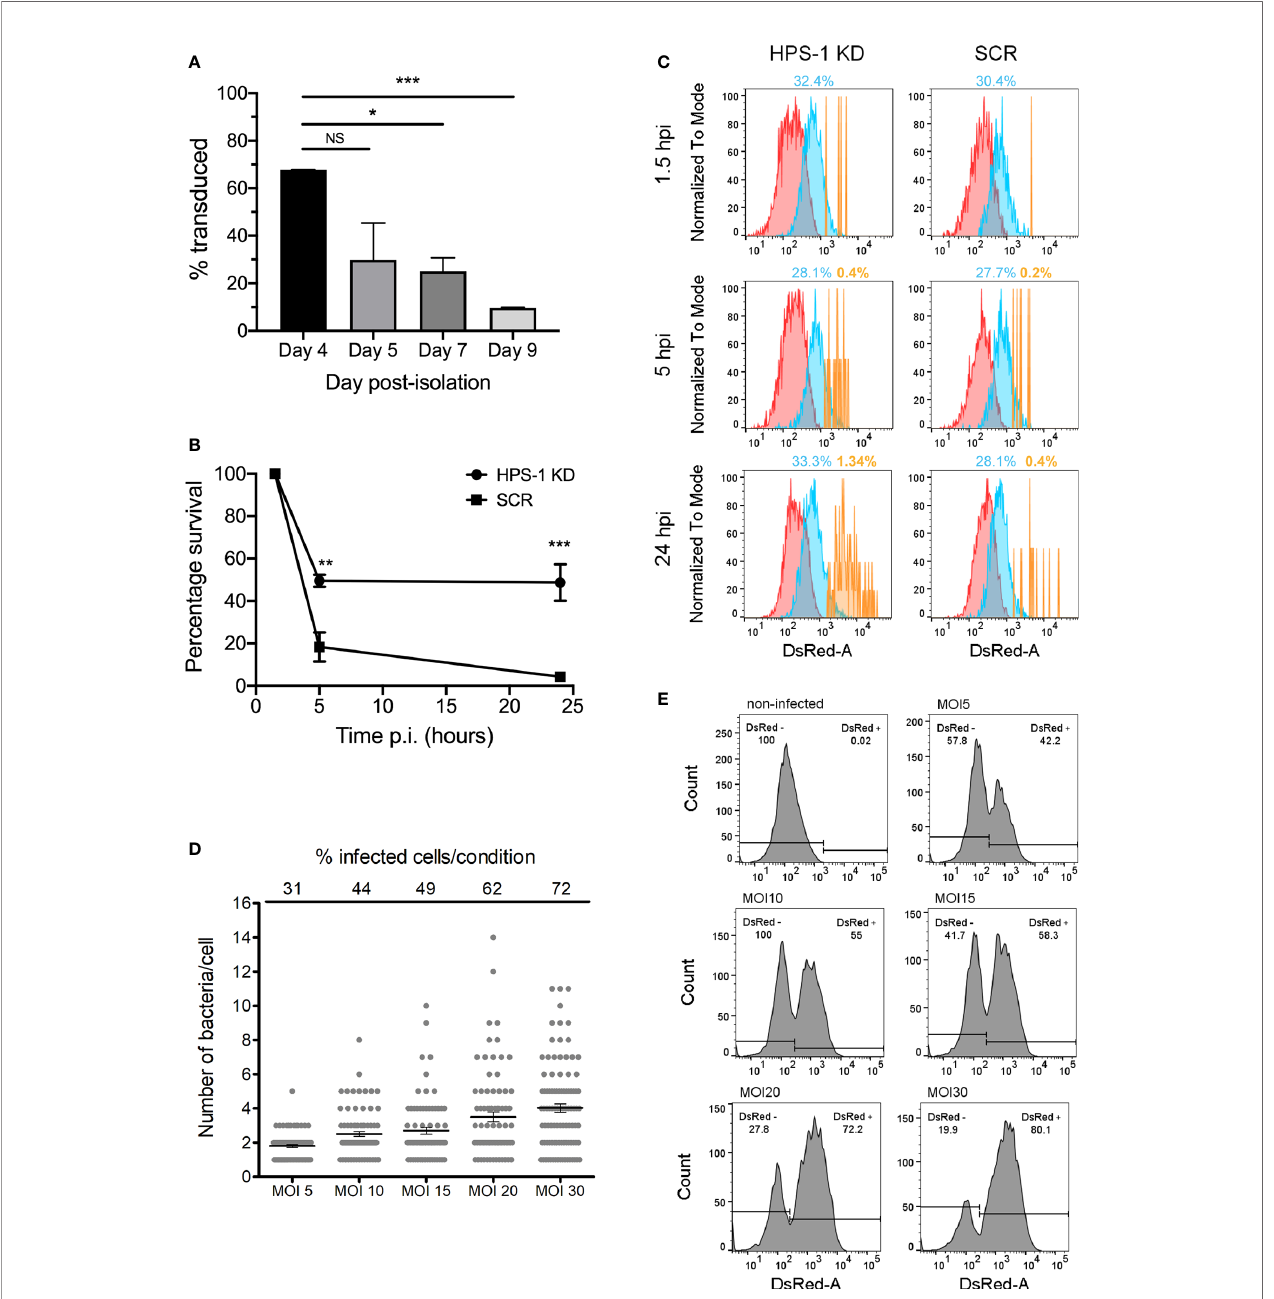
FIGURE 2 | shRNA-mediated knockdown in BMDMs. (A) BMDMs were transduced at different days post-isolation. After incubation with 5 m g/ml puromycin for 48 hours, cell viability was evaluated with alamar blue assay. Percentage of survival are: Day 4 67.72%, Day5 26.84%, Day 7 25.02%, Day 9 9.63%. Values are mean ± SEM of two independent measurements. NS, non-signi fi cant; * P < 0.05 ; ** P < 0.01; *** P < 0.005 . (B) BMDM cells were transduced with lentiviral particles encoding a non-target scrambled sequence (SCR) or encoding a sequence targeting HPS-1 (HPS-1 KD). After selection with 5 µg/ml puromycin, cells were infected with S . Typhi wild-type, lysed at three times post-infection (1.5, 5 or 24 h) and CFUs were enumerated. Values are means ± SEM of two independent experiments performed in triplicate. P values were determined by the Student´s t test and are indicated when P < 0.05. (C) BMDMs HPS-1 Knockdown (HPS1 KD) or control (Scrambled shRNA; SCR) were infected with S . Typhi:: mCherry (MOI 10). At different times post-infection (1.5, 5 and 24 hours post-infection), cells were fi xed with 4% PFA and analyzed by fl ow cytometry. The three subpopulations non-infected (N) (red), 1-3 bacteria (M) (blue) and >3 bacteria (H) (yellow) are shown and the percentage of the M and H populations are indicated. (D, E) BMDMs were infected with S . Typhi:: mCherry at different multiplicity of infection (MOI). After 1.5 hours- post infection, cells were fi xed with 4% PFA and analyzed by fl uorescence microscopy (D) or fl ow cytometry (E) to determine the percentage of infected cells and the average number of bacteria per cell. For quanti fi cation of the number of bacteria per cell for fl uorescence microscopy, 85 (out of 272 total; MOI 5), 83 (out of 190 total; MOI 10), 72 (out of 147 total; MOI 15), 80 (out of 128 total; MOI 20) and 88 (out of 122 total; MOI 30) infected cells were